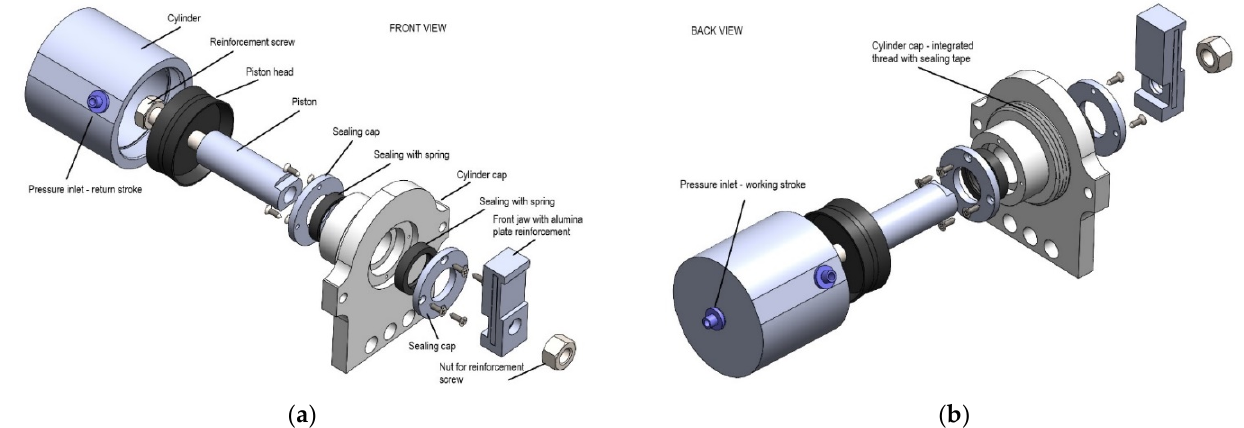
Figure 9. The actuator: ( a ) Front exploded view; ( b ) Back exploded view.